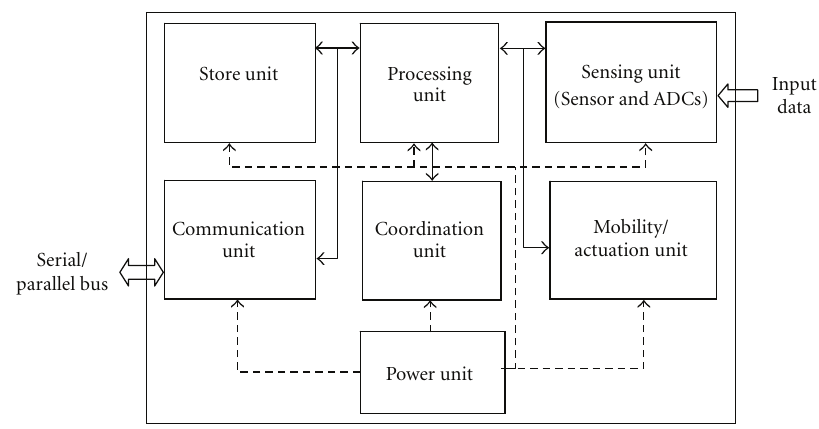
Figure 1: A common multimedia sensor node